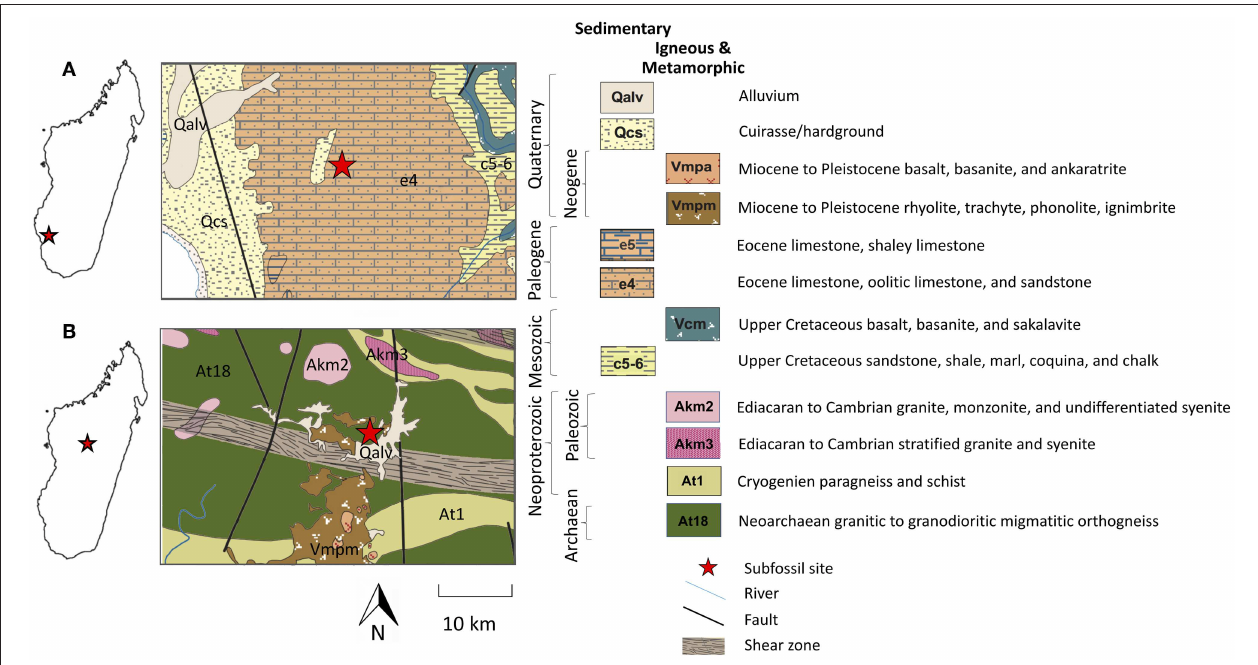
FIGURE 1 | Maps showing the location of our two study sites in Madagascar, as well as the geology at Ankilitelo/Mikoboka (A) , and Ampasambazimba (B) . Geologic maps were modified from Roig et al.